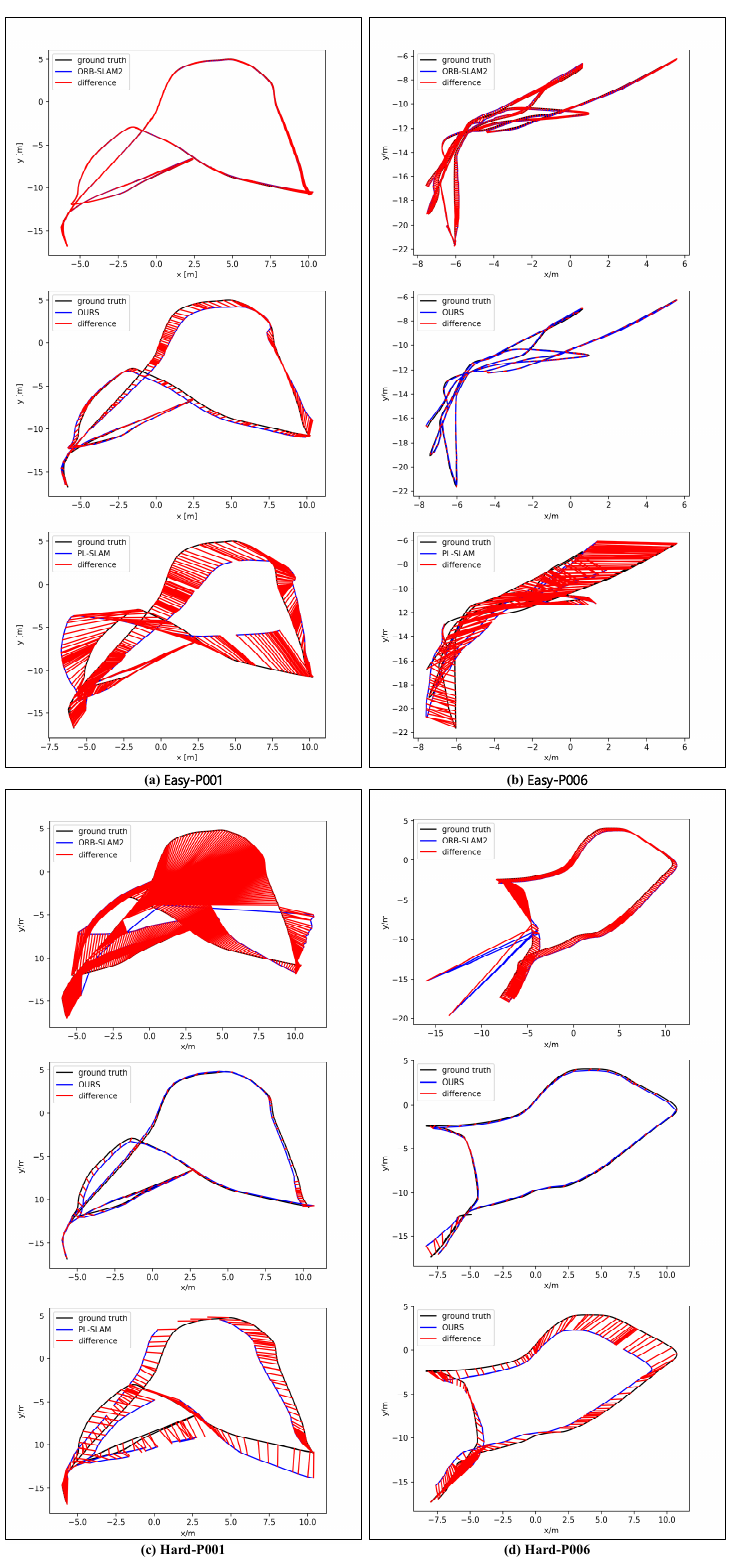
Figure 11. Absolute trajectory errors on the TartanAir dataset. ( a – d ) are the ATE comparison of different algorithms in sequences Easy-p001, Easy-P006, Hard-P001 and Hard-P006, respectively. The black line in the figure is the ground-truth, the blue line is the estimated trajectory, and the red area represents the difference between the ground-truth and the estimated